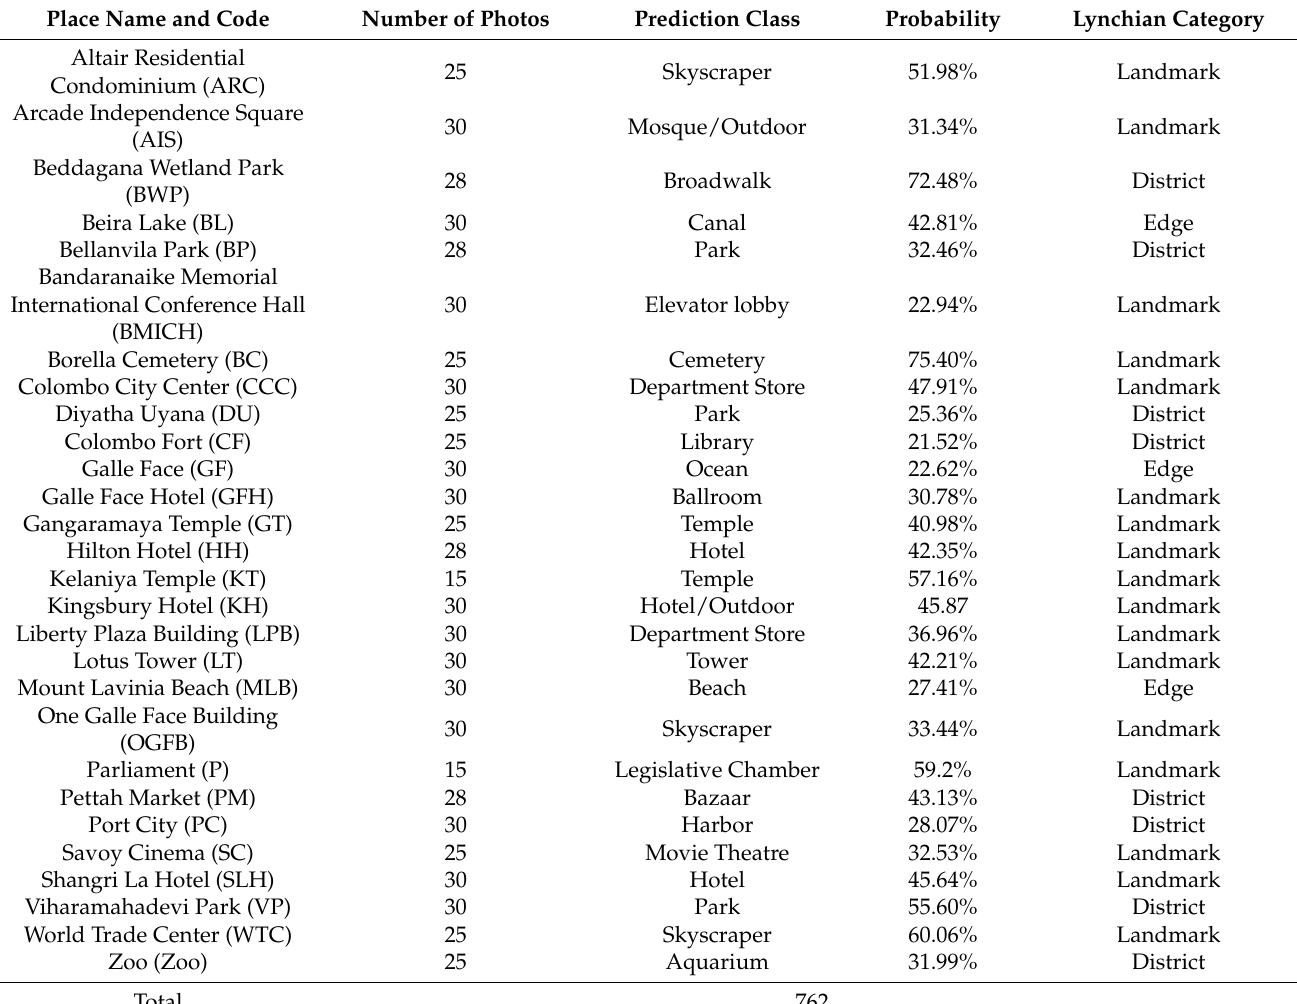
Table 1. Identifying Lynchian